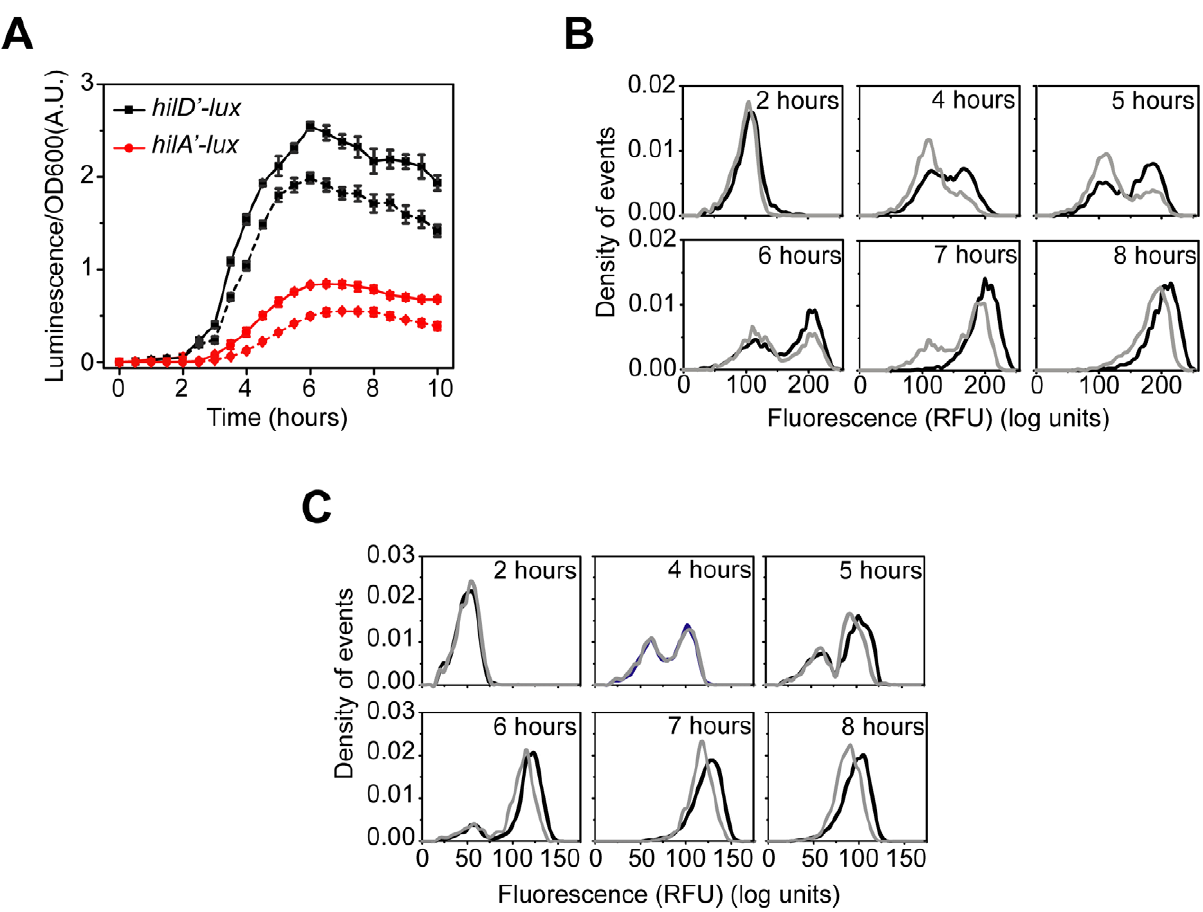
Figure 3. HilC and RtsA amplify SPI1 gene expression. (A) Comparison of time-course dynamics for P hilD (pSS074, black) and P hilA (pSS077, red) promoter activities in wild type (solid lines) and a D hilC D rtsA mutant (CR350, dashed lines) as determined using luciferase transcriptional reporters. (B and C) Comparison of P hilA (pSS055, B) and P hilD (pSS072, C) promoter activities in wild type (black) and a D hilC D rtsA mutant (CR350, grey) as determined using GFP transcriptional reporters and flow cytometry. Note that the loss of HilC and RtsA causes both a delay and decrease in P hilA promoter activity whereas it causes only a decrease in activity in the case of the P hilD promoter. Experiments were performed as described in Figure 1 .